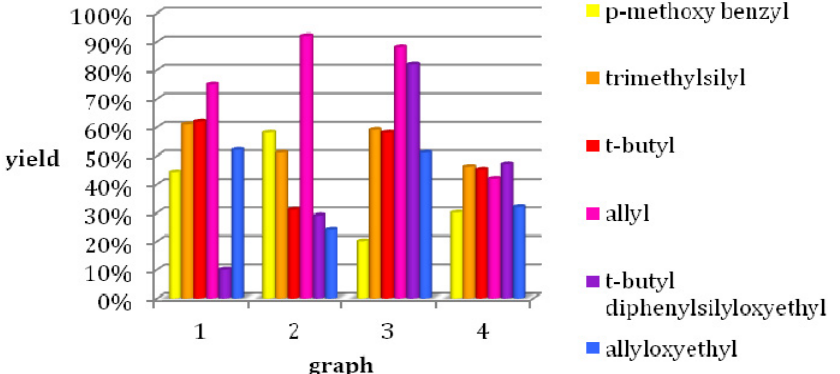
Figure 2. Yields for different steps in the synthesis of the six SNAP derivatives. Graph 1: synthesis of β -ketoesters 8 – 13 ; graph 2: Biginelli cyclization of 15 – 20 ; graph 3: synthesis of 22 – 27 in a one-pot two-step reaction; graph 4: synthesis of the SNAP derivatives 29 – 34